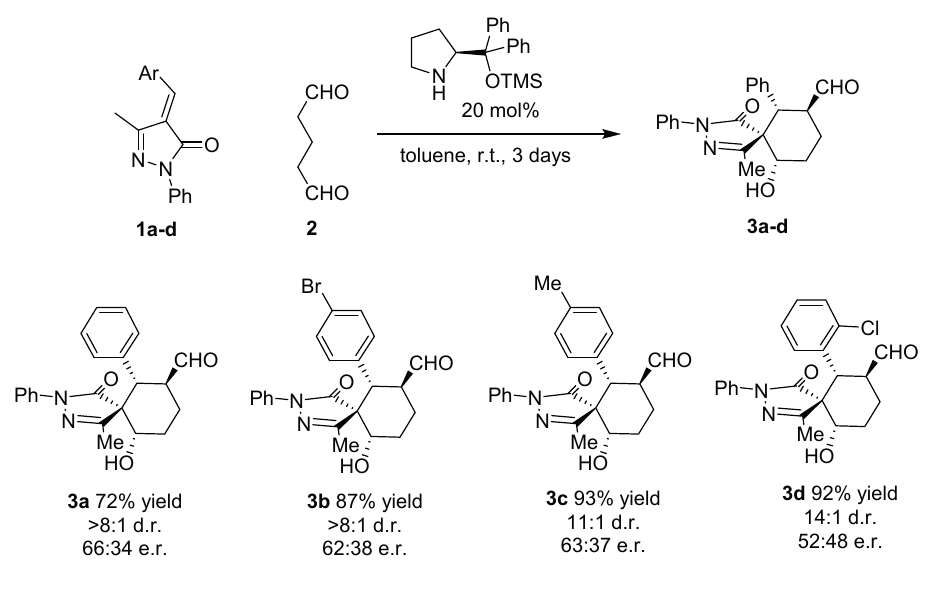
Figure 2. Reaction scope.